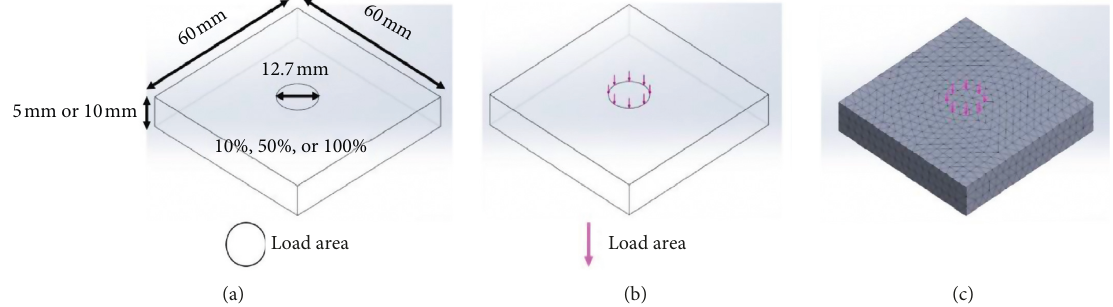
Figure 1: Location and dimensions of load area for the structural analysis. (a) Modeling. (b) Load value input. (c) Mesh creation.